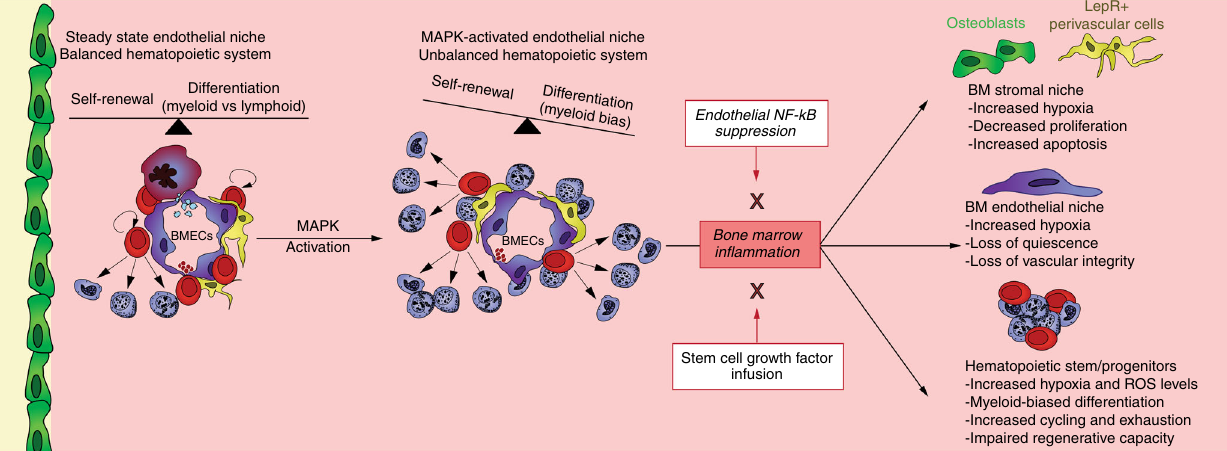
Fig. 10 Schematic describing the impact of in fl ammation on BM niche cells and HSPCs. Endothelial MAPK activation drives an NF-kB-dependent in fl ammatory stress response within the bone marrow leading to functional defects in the vascular niche and HSPCs. Suppression of in fl ammation by inhibition of endothelial NF-kB or infusion of SCGF restores vascular integrity, resolves HSPC and niche defects, and augments post-myelosuppressive hematopoietic